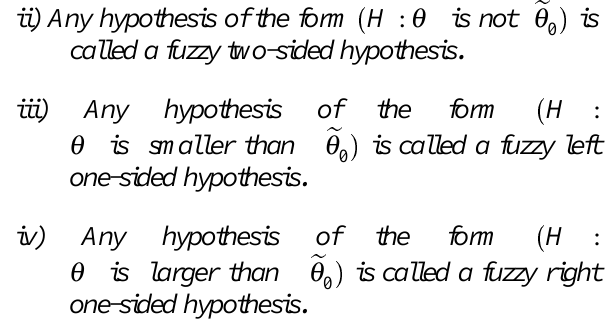
Fig. 8. A Π and A